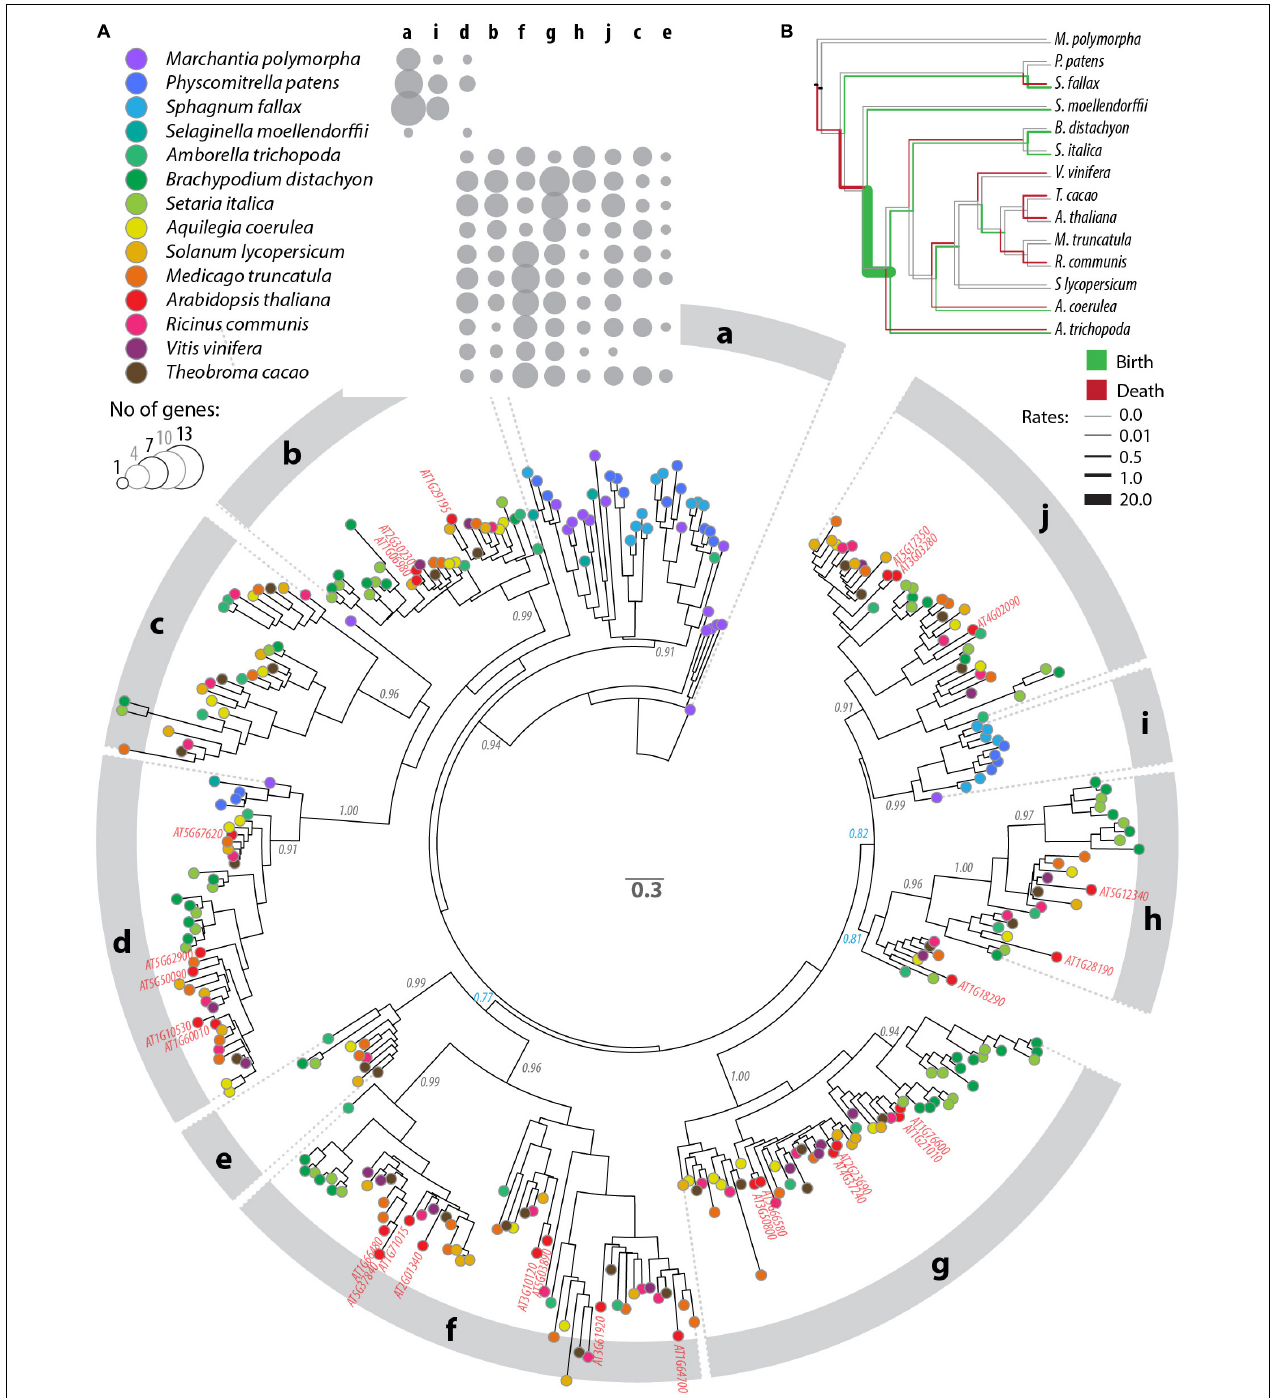
FIGURE 3 | Phylogenetic relationships between DUF4228 proteins in the complete proteome of 13 Embryophyta species. (A) Tree obtained by a maximum likelihood analysis, with the number of substitutions per site used as branch length, and branch support determined by an approximate likelihood ratio test (black labels if ≥ 0.90, blue otherwise). Terminal nodes are color-coded according to plant species (key shown in the upper panel). A. thaliana identifiers are labeled in red on the tree. Phylogenetic groups are labeled a to j on the outer circle. The upper panel shows the number of genes per species and per phylogenetic group as bubbles of increasing size. (B) Species tree showing rates of PADRE domain gain (green) and loss (red) in the evolution of Embryophyta as calculated with BadiRate (Librado et al., 2012). Neutral branches are shown in gray.